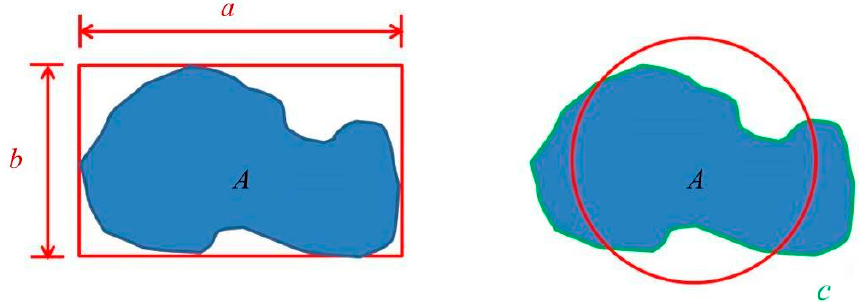
Figure 2. Parameters of spheroidization degree definition.